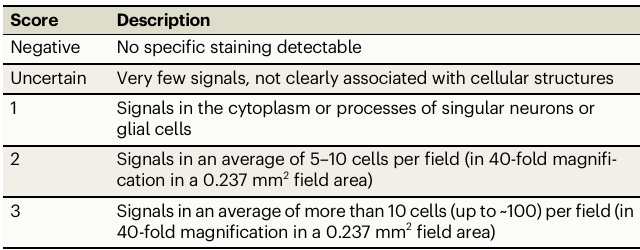
Table 2 | Scoring of RNAscope ISH and IHC signal in brain